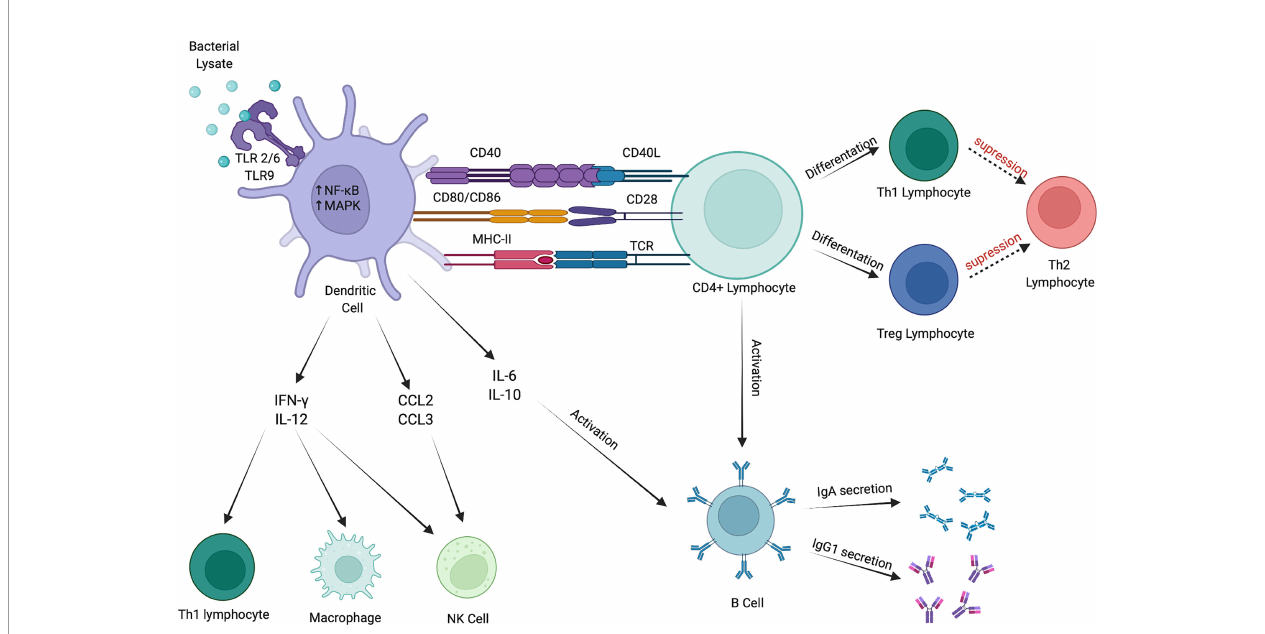
FIGURE 1 | Immunomodulatory effects of bacterial lysates. BLs stimulate immune response via numerous pathways. They activate DCs via TLR2/6 and TLR9. Mature DCs produce cytokines that stimulate Th1 lymphocytes, macrophages and NK cells. Furthermore, they promote CD4+ lymphocytes to differentiate into Th1 and Treg subtypes and activate B cells to secrete IgA and IgG1. Created with